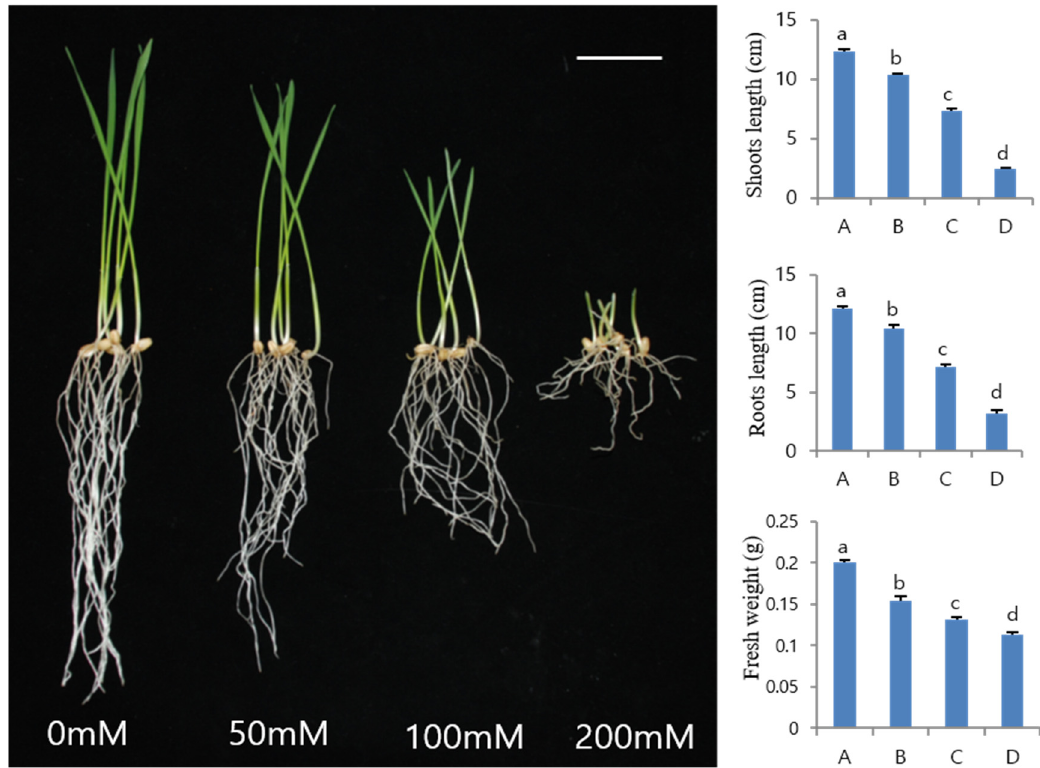
Figure 2. Development of wheat sprouting at 6 days under di ff erent NaCl concentration treatments. A, 0 mM NaCl; B, 50 mM NaCl; C, 100 mM NaCl; and D, 200 mM NaCl. The means and standard deviations (SD) were calculated from three biological replicates. Letters a-d denote significant di ff erences ( P < 0.05). The scale bars represent 5 cm.